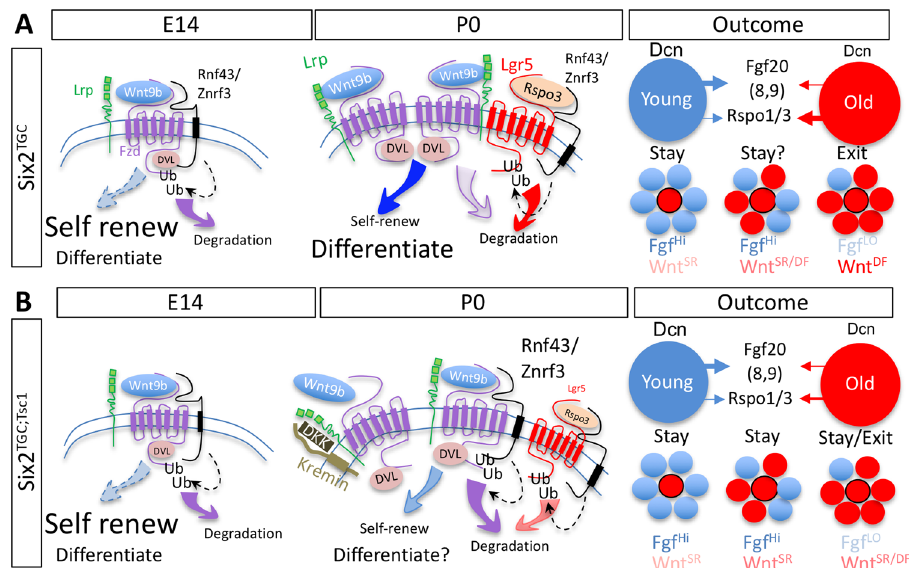
Fig. 5 A parsimonious hypothesis of how NPC coordinate the cessation of nephrogenesis. A In E14 Six2 TGC controls, important Wnt agonists are transcribed but poorly translated, resulting in lower Wnt signal intensity and preference for self-renewal (SR). Transcript levels for the niche-retention signal Fgf20 are relatively high 38 . At P0, the increased translation of Rspo1/3 and additional factors increase the stability of Fzd/Wnt complexes; Wnt signal intensity now promotes differentiation (DF) over self-renewal. We assume other factors in the niche environment, including Decorin, can modulate this in trans. If enough neighbors are in this state, an environment low in FGF and high in Rspo1/3 will drive the NPC to differentiate en masse. B In Six2 TGC;Tsc1 cells, translation of Rspo1/3 is less ef fi cient, and that of antagonists DKK, Kremen, and RNF43 is more ef fi cient. As a result, cells in the population are experiencing lower Wnt signals, delaying coordinated cessation by an unknown amount suf fi cient to produce more nephrons. Experimental data suggest this delay is ~12 h. This environment may also increase the number of nephrons forming during arcading (the period during which the entire population remaining in the niche differentiates 32